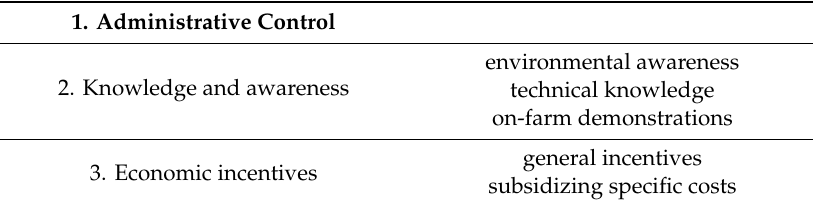
Table 3. Actions to promote the adoption of sustainable practices by